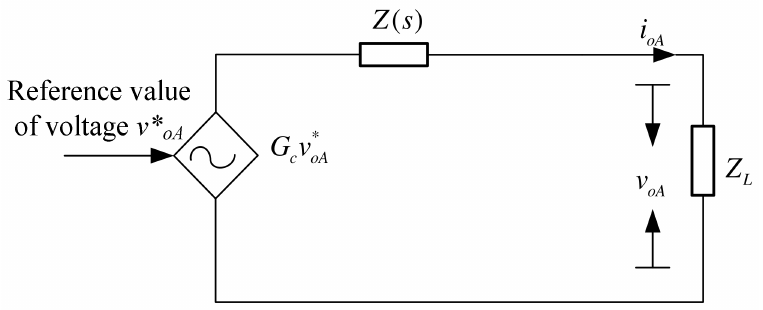
Figure 7. Thevenin’s equivalent circuit of VSSG closed loop